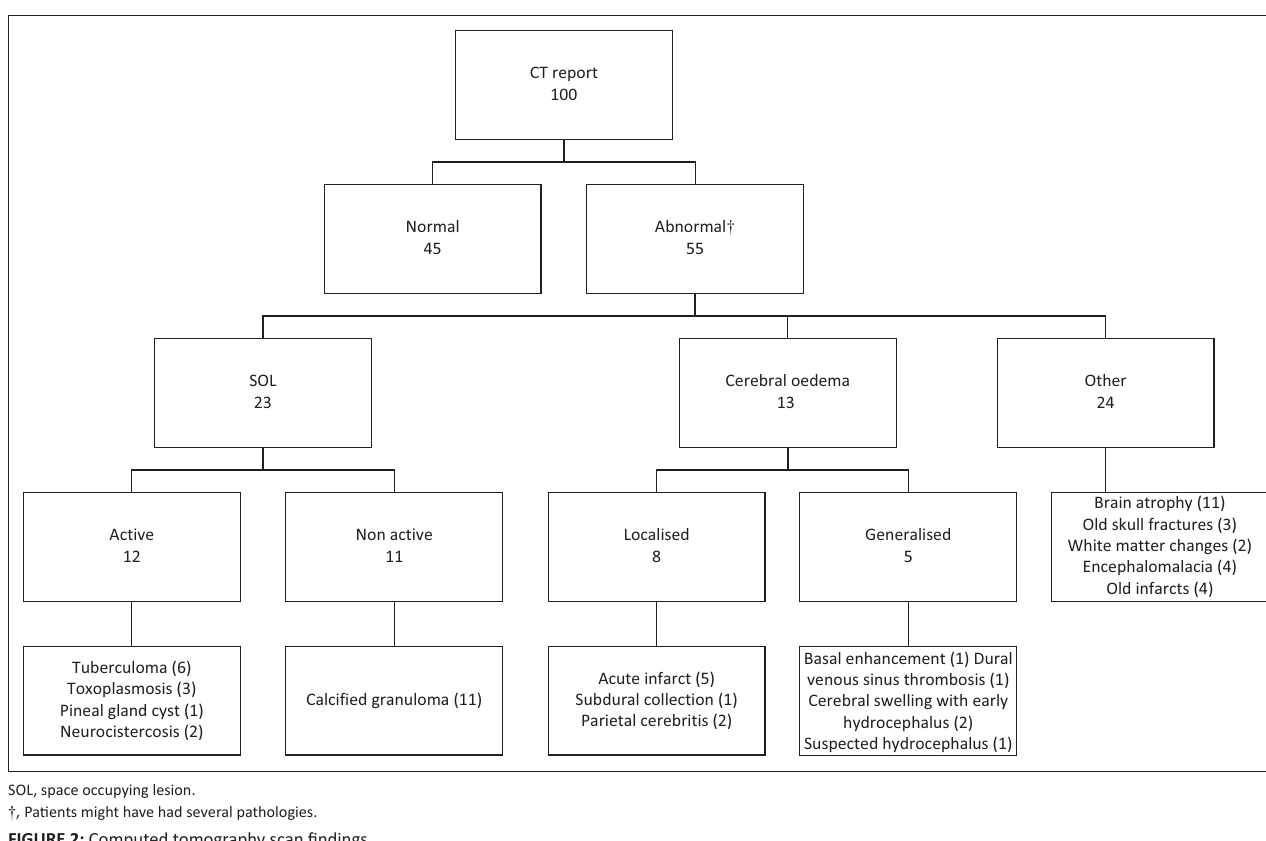
FIGURE 2: Computed tomography scan TABLE 3: Univariate and multivariate analyses of potential predictors of patients with active space-occupying lesion and cerebral oedema. Potential predictors for at-risk patients